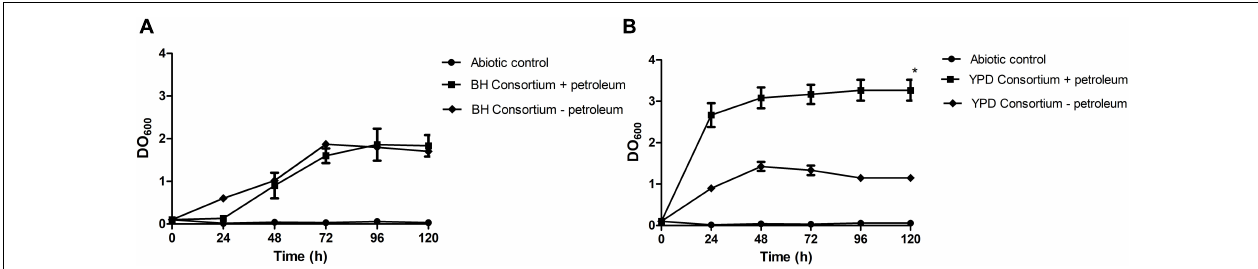
FIGURE 1 | Consortia growth curves in mineral medium with 1% (v/v) sterile petroleum. (A) Growth curve of the BH consortium + petroleum, compared to the negative controls, one containing only mineral medium and autoclaved oil (Abiotic control), and the other containing BH consortium in mineral medium without oil (BH consortium – petroleum). (B) Growth curve of the YPD consortium + petroleum, compared to the negative controls (Abiotic control and YPD consortium – petroleum). The statistical significance was analyzed by a two-way ANOVA, and p < 0.05 was considered significant (* p < 0.05).